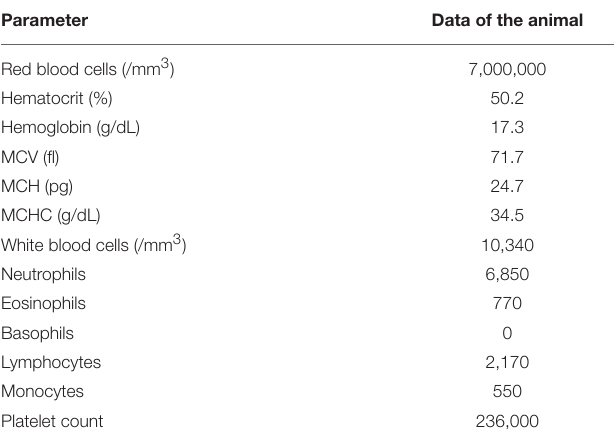
TABLE 1 | Preoperative hematology.